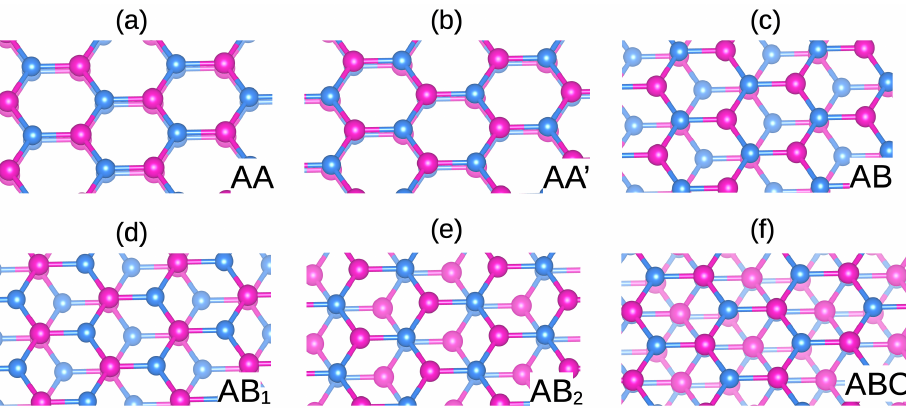
Figure 2. Top views of the sp 2 polytypes of BN with boron and nitrogen atoms indicated by magenta and blue spheres, respectively. The atomic stacking of the individual layers are: ( a ) AA, ( b ) AA’ or hBN, ( c ) AB or bBN, ( d ) AB 1 , ( e ) AB 2 , and ( f ) ABC or rBN. The six stackings are represented as an artist view